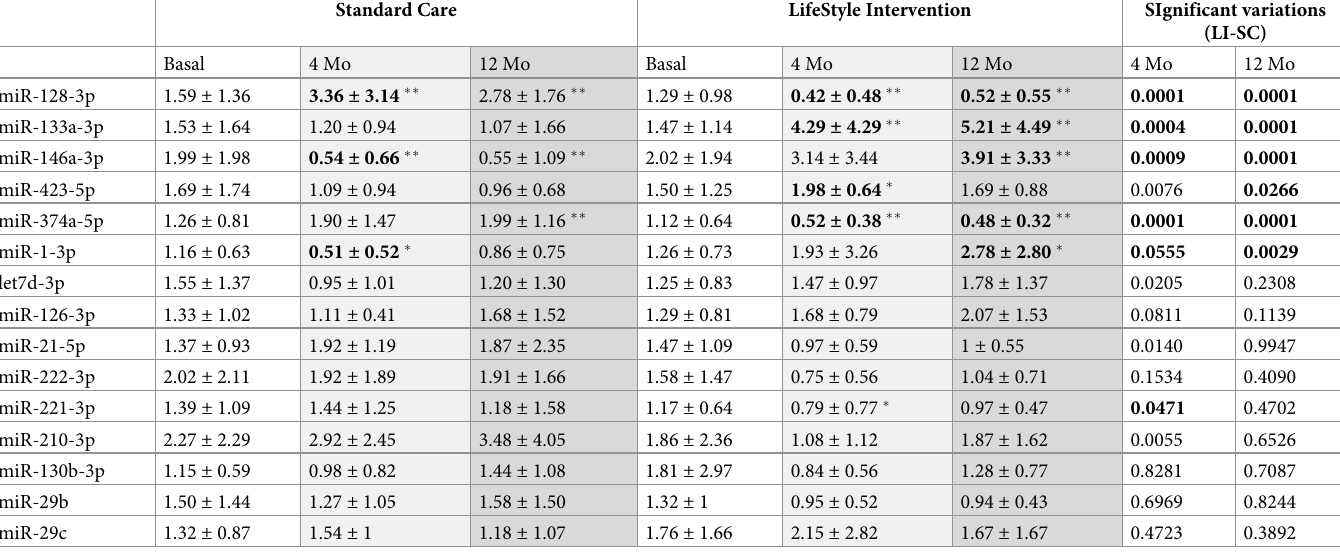
Table 2. Variations of circulating miRNAs (ratios of Ct values) in serum from all subjects involved in the Standard Care (SC) or LifeStyle Intervention protocol (LI). Standard